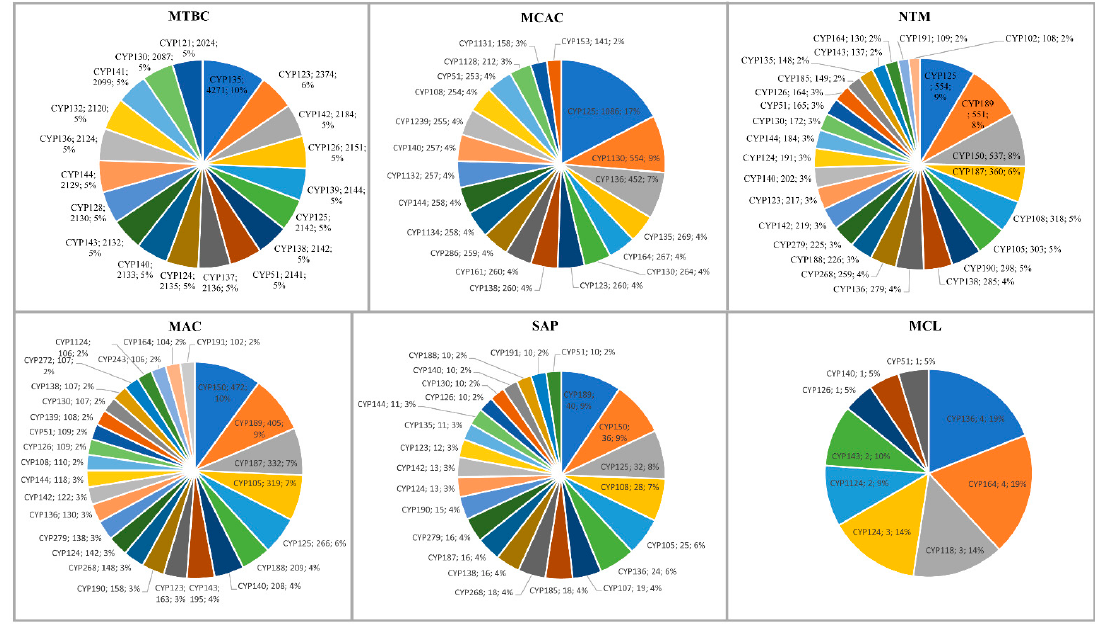
Figure 2. Comparative analysis of P450s families in six mycobacterial categories. The P450 family, members, and their percentage in the total number of P450s in a category are presented in the figure.